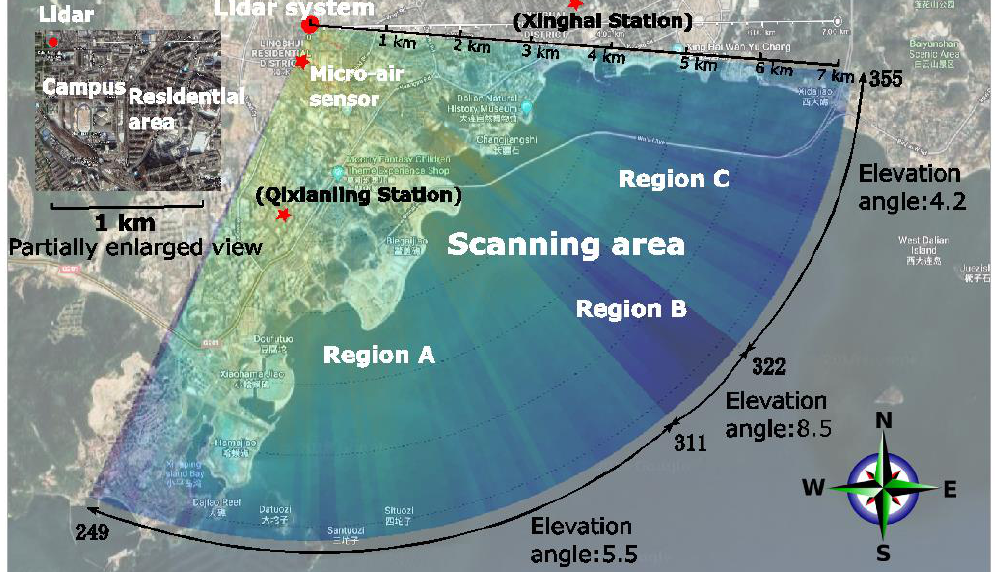
Figure 5. Experimental site map, the SLidar system was placed on the 7th floor balcony of the education building in Dalian University of Technology (DLUT) during the scanning measurements. The Qixianling and Xinghai national pollution monitoring stations can measure the particle concentrations every hour. The Micro-air sensor (Fairsense) was able to measure PM10 and PM2.5 concentrations every 15 min. Location of the lidar system: 38 ◦ 53 (cid:48) 00.7”N, 121 ◦ 31 (cid:48) 37.2”E. Azimuth angles for regions A, B and C are 249 ◦ –310 ◦ , 311 ◦ –321 ◦ , 322 ◦ –355 ◦ , respectively. The direction of east is defined as 0 ◦